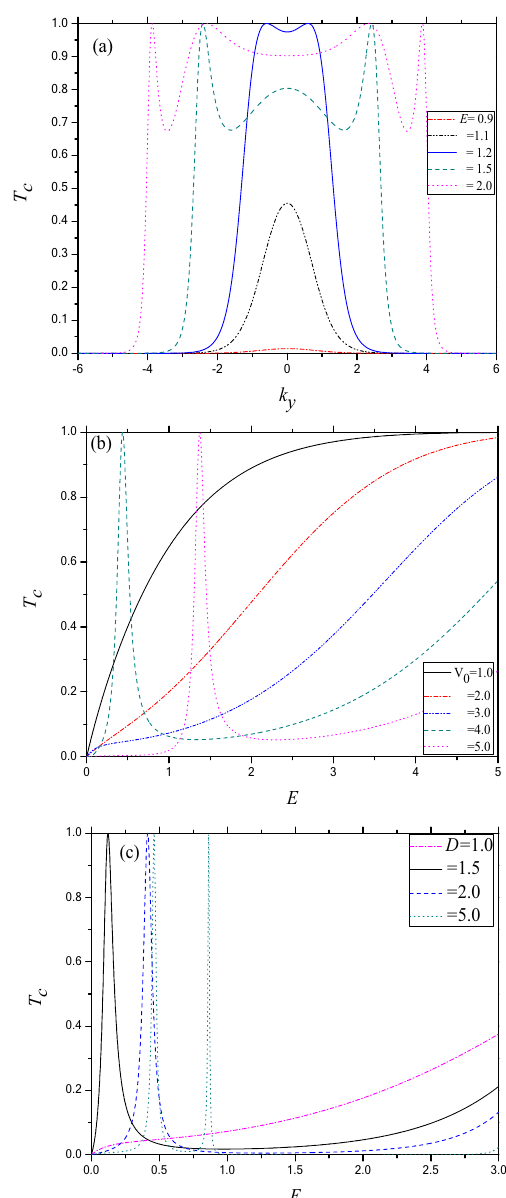
Figure 2. ( a ) Transmission coefficient ( T c ) as a function of the y-component of wave vector ( k y ) through a static phosphorene electrostatic barrier along Г–X direction. For V 0 = 1 and D = 5. Dash dot (red) line for E = 0.9; Dash double dot (black) line for E = 1.1; Solid (blue) line for E = 1.2; Dash (green) line for E = 1.5 and Dot (purple) line for E = 2.0. ( b ) Same as ( a ) but as a function of incident energy ( E ) for k y = 0 and D = 1. Solid (black) line for V 0 = 1; Dash dot (red) line for V 0 = 2; Dash double dot (blue) line for V 0 = 3; Dash (green) line for V 0 = 4; Solid (black) line for V 0 = 1; Dot (purple) line for V 0 = 5. ( c ) Same as ( b ) but for k y = 0 and V 0 = 3. Dash dot (purple) line for D = 1; Solid (black) line for D = 1.5; Dash (blue) line for D = 2.0; Dot (green) line for D =